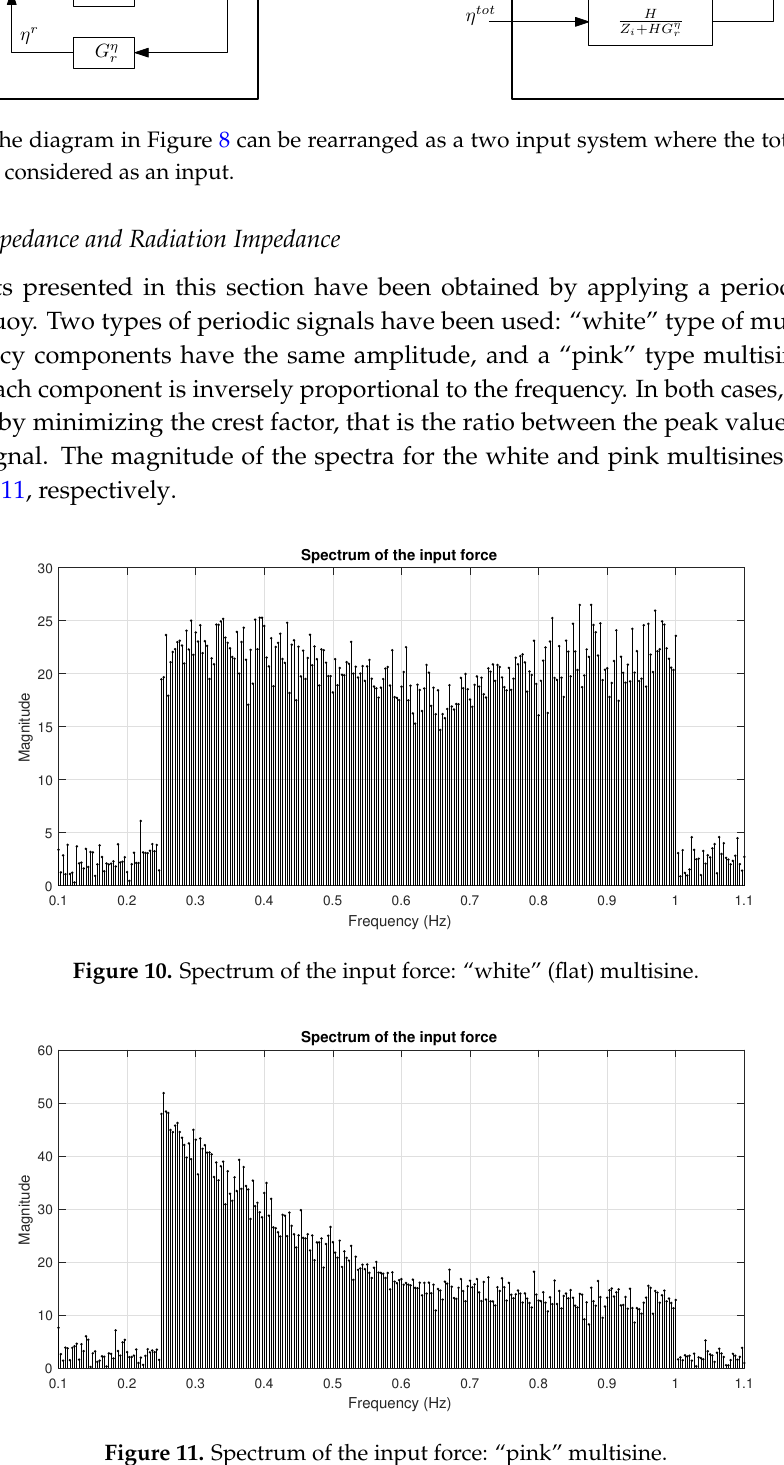
Figure 11. Spectrum of the input force: “pink”